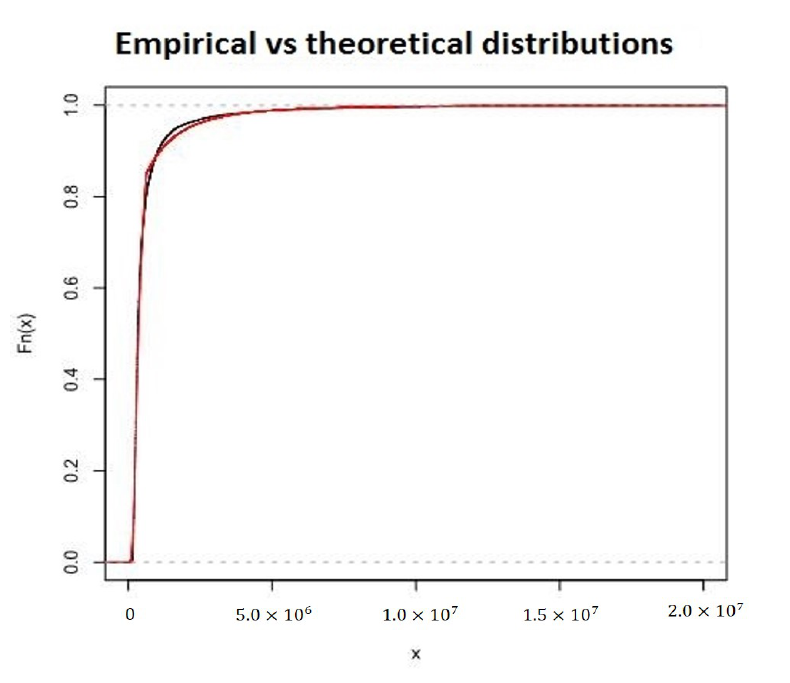
Figure 9. Lognormal–GPD–Gamma (red) versus empirical (dark) distribution functions. Table 9. AIC and BIC indices for a comparison between different